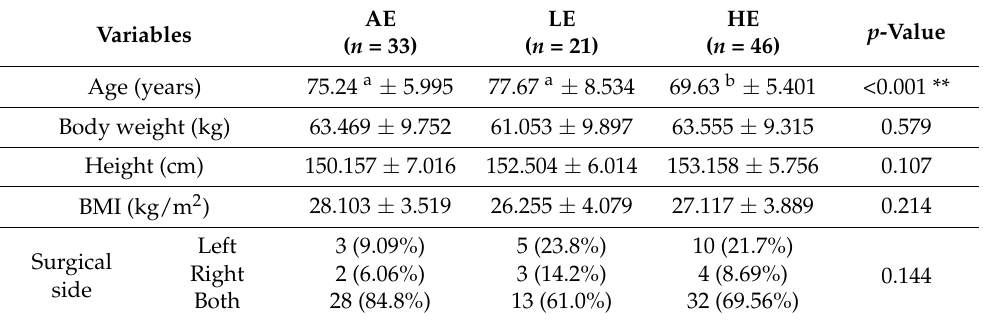
Table 1. Comparison of the groups’ characteristics.